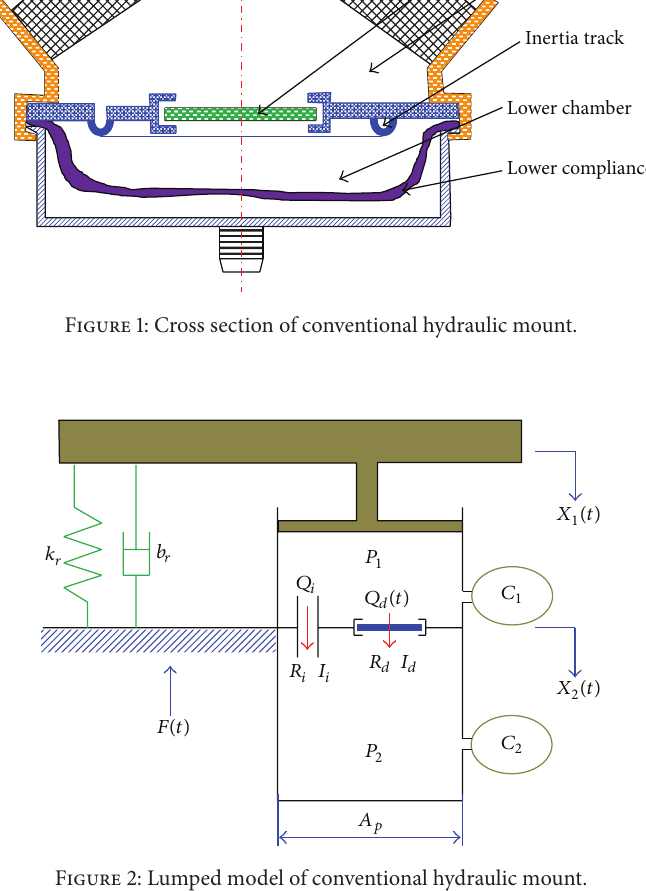
Figure 2: Lumped model of conventional hydraulic mount.